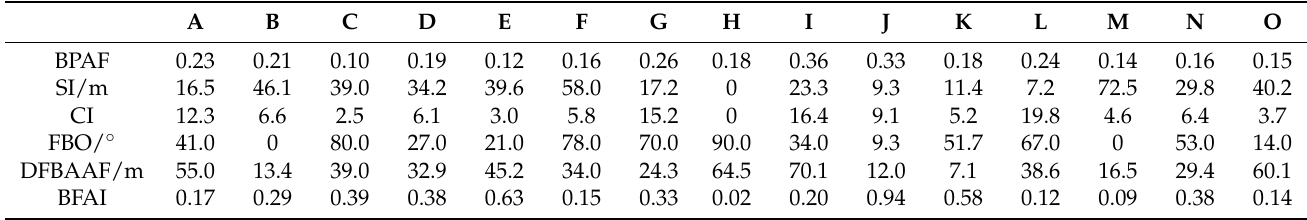
Table 4. Values of urban form indices of the fifteen selected